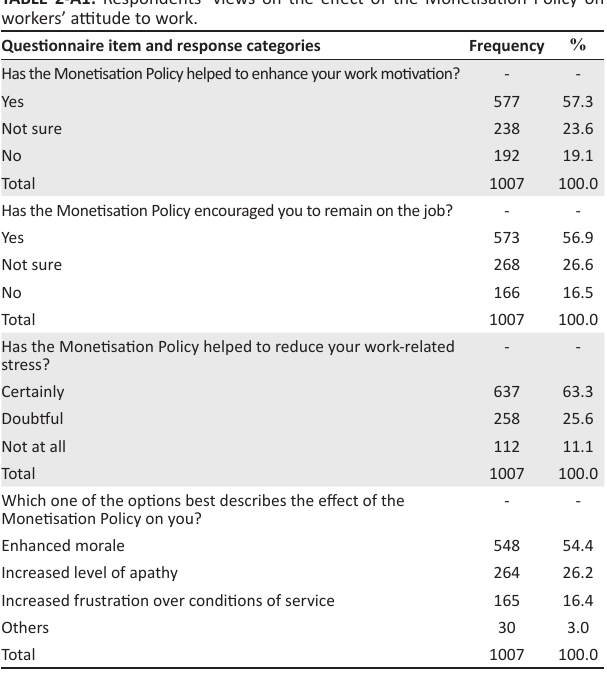
TABLE 2-A1: Respondents’ views on the effect of the Monetisation Policy on workers’ attitude to work. Questionnaire item and response categories